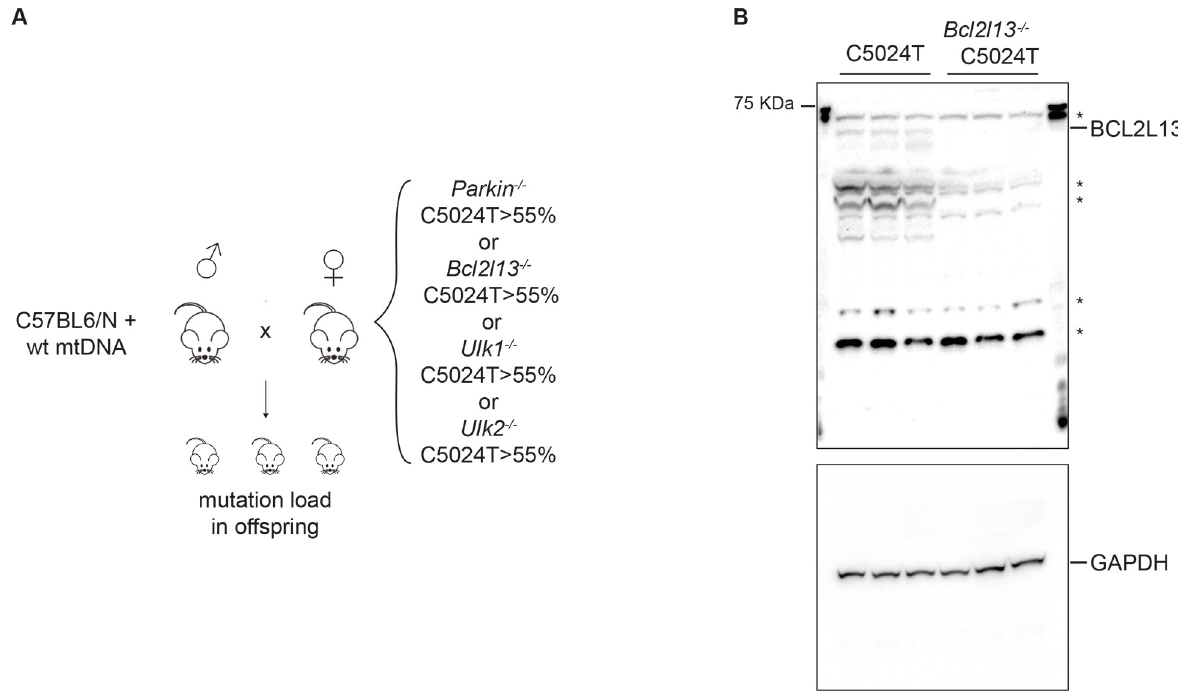
Fig 1. (A) Overview of the experimental setup. Female mice transmitting the pathogenic C5024T mutation in combination with Parkin -/- , Bcl2l13 -/- , Ulk1 -/- , or Ulk2 -/- alleles were crossed to C57BL6/N males with wild-type (wt) mtDNA and the mutation load was measured in the resulting offspring. (B) Western blots analysis of BCL2L13 protein levels in mouse liver (n = 3; � = unspecific bands) , levels of GAPDH shown as loading control.